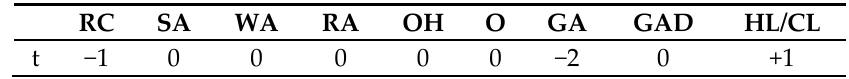
Figure 8. FIR mask obtained for heating load (HL) and cooling load (CL) models.